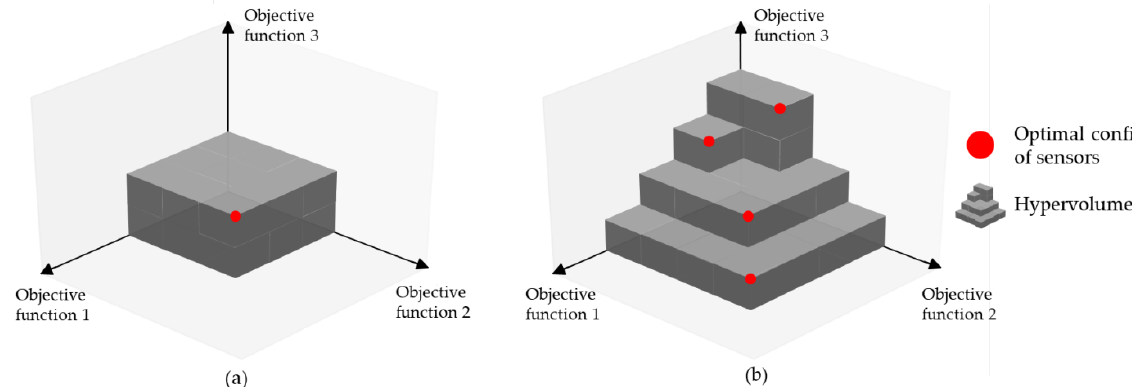
Figure 2. Characterization of the total gain for a given number of sensors using the hypervolume indicator.